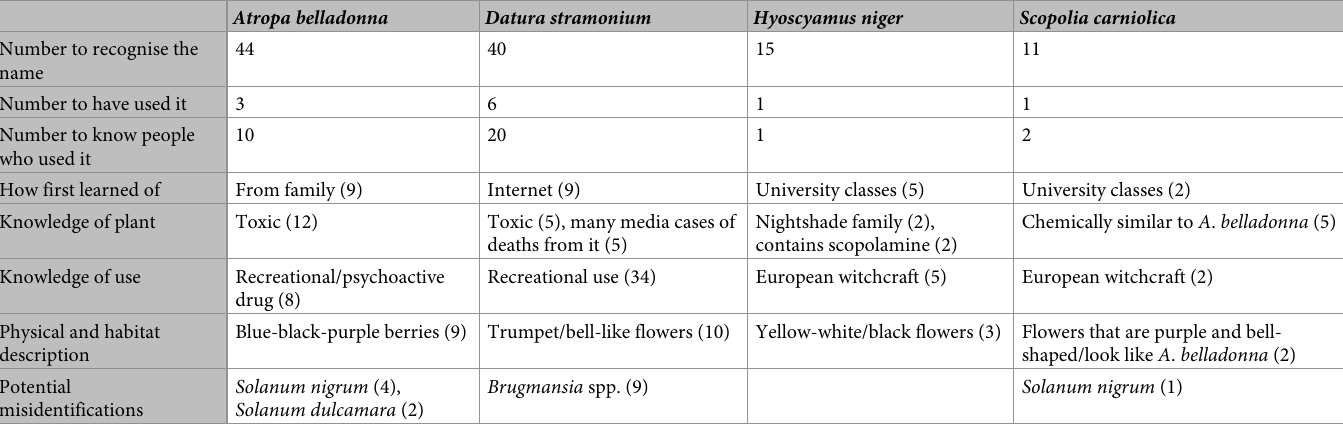
Table 1. Comparison of most frequent responses. N =